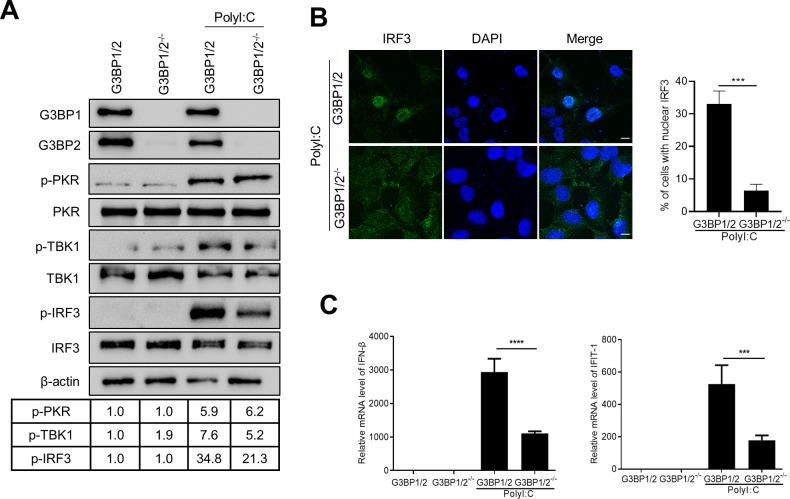
Depletion of SGs scaffold proteins reduces poly I:C-induced IRF3-IFN-β signaling.(A) H1299 G3BP1/2 positive cells and H1299-G3BP1/2-/- cells were transfected with poly I:C (1 μg/ml) for 6 h. The levels of p-PKR, PKR, G3BP1, G3BP2, p-TBK1, TBK1, p-IRF3, IRF3, and actin were determined by Western blot analysis. Images are representative of two independent experiments. The signals of protein bands were determined by Image J. The intensities of p-PKR, p-TBK1, p-IRF3 were normalized to total PKR, TBK1, IRF3. The ratio of p-PKR, p-TBK1, p-IRF3 in poly I:C transfected cells or H1299-G3BP1/2-/- cells to H1299 G3BP1/2 positive cells was were shown. (B) H1299 G3BP1/2 positive cells and H1299-G3BP1/2-/- cells were transfected with poly I:C. The nuclear translocation of IRF3 was examined by immunostaining. Scale bars: 10 μm. Images are representative of three independent experiments. The bar graphs on the right panel indicate the percentage of nuclear IRF3 positive cells to total cells, which were calculated by 20 random fields, presented as mean ± SD. ***, P < 0.001. (C) H1299 G3BP1/2 positive cells and H1299-G3BP1/2-/- cells were transfected with poly I:C. The induction of IFN-β and IFIT-1 was quantified by quantitative RT-PCR. The bar graphs show relative expression levels of IFN-β or IFIT-1 from three independent experiments, presented as mean ± SD. ***, P < 0.001; ****, P < 0.0001.